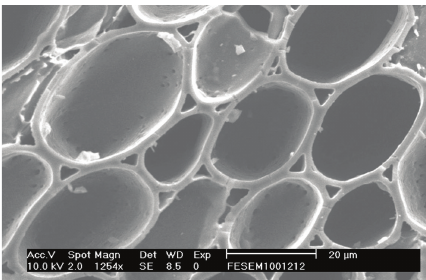
Figure 2: Cross-section SEM image of cavern pores in charcoal carbonized at 900 ∘ C.